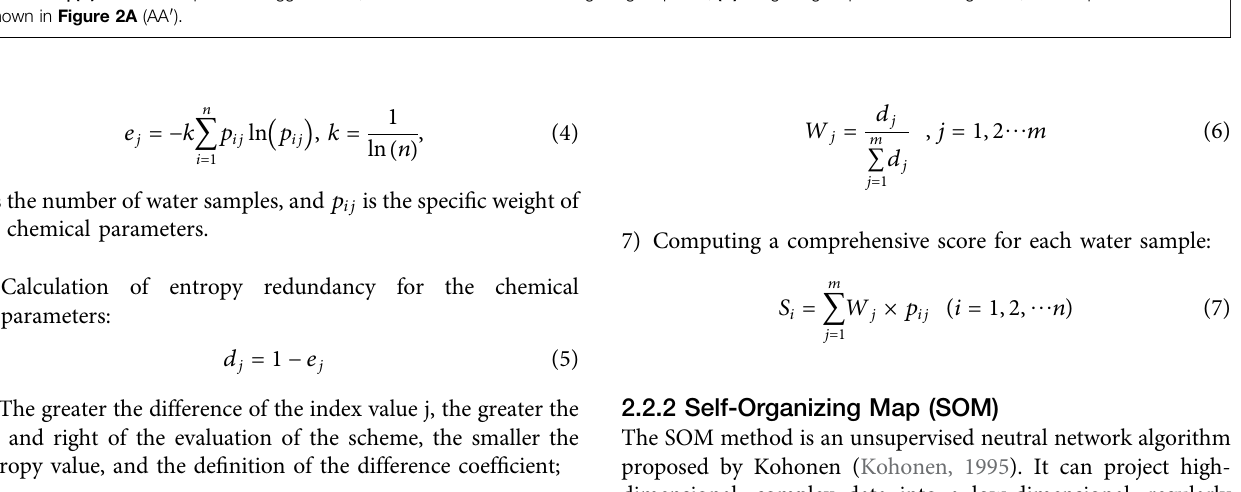
Frontiers in Environmental Science |